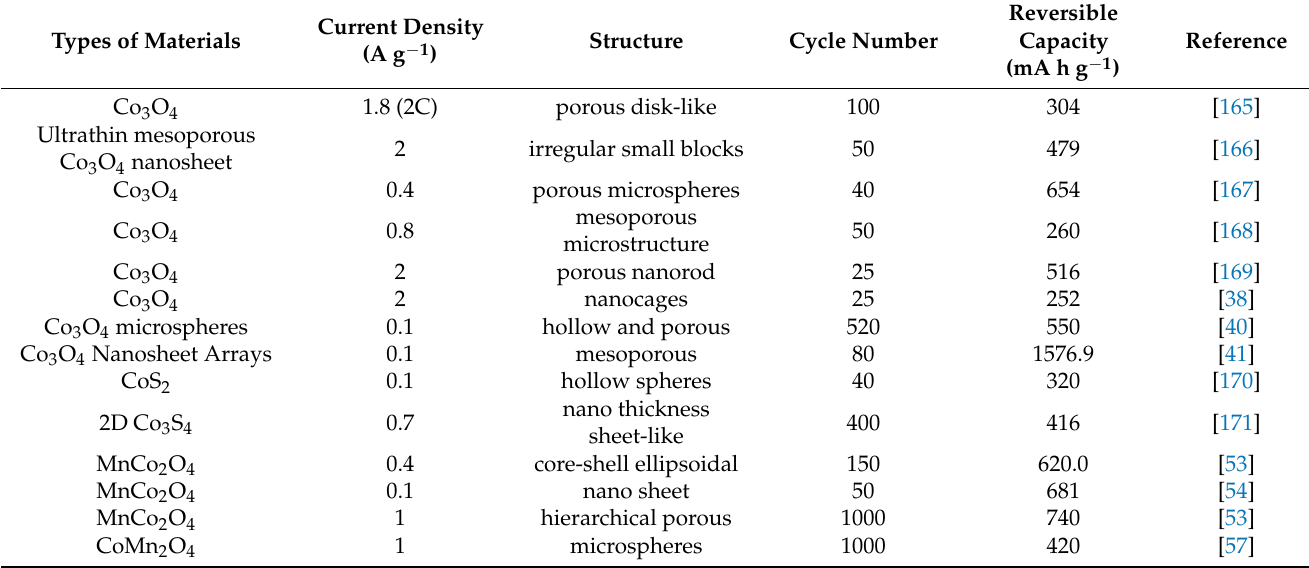
Table 2. Comparison of electrochemical properties of cobalt compounds, carbon nanomaterials and cobalt-carbon